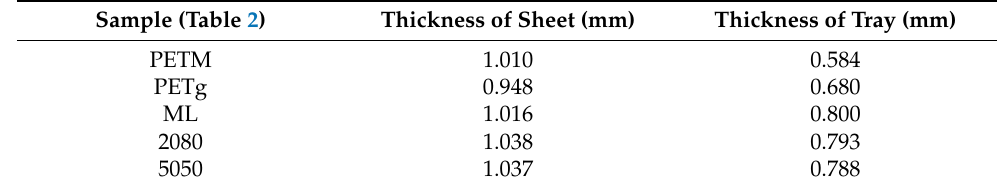
Figure 10. Haze of the sheets, extruded with the Labtech co-extrusion unit, and the thermoformed trays. Table 4. Thicknesses of the extruded sheets, and the thermoformed